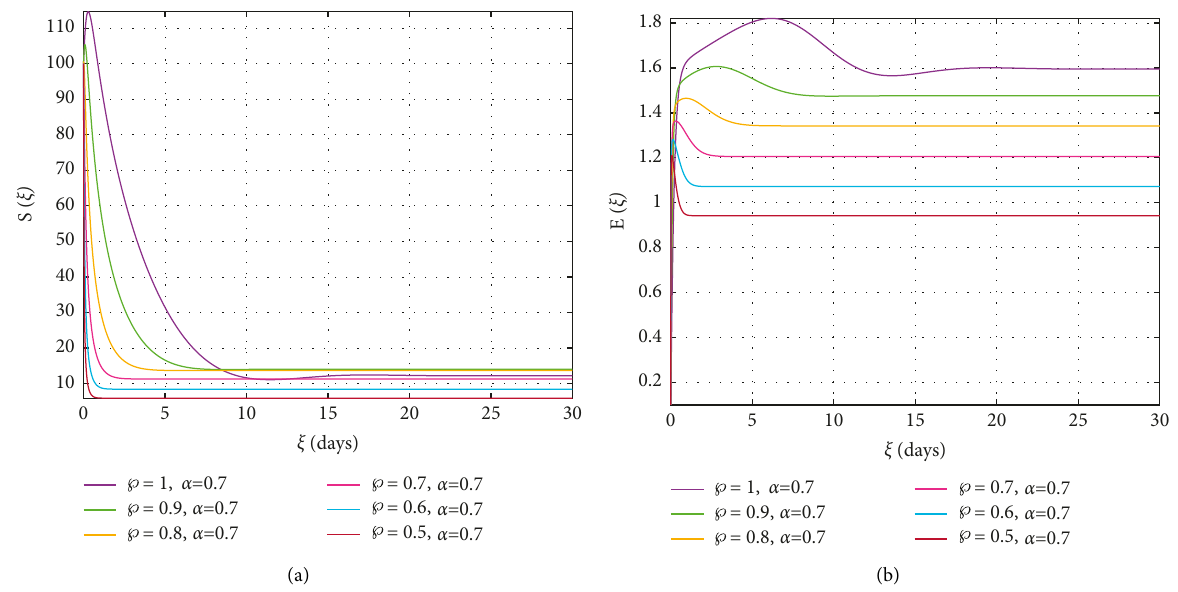
Figure 7: (a) Displays of susceptible individuals S ( ζ ) (b) Displays of exposed individuals E ( ζ ) using a Newton polynomial approach for decreasing fractal-dimension ℘ and fixed α � 0 .